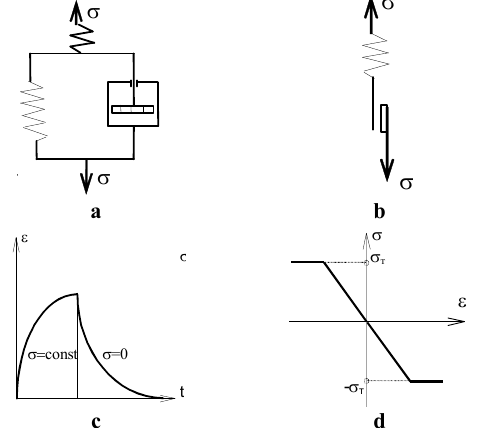
Fig 10. Rheological models ( а , c) and rheological curves ( в , г ) Kelvin - Foygt and